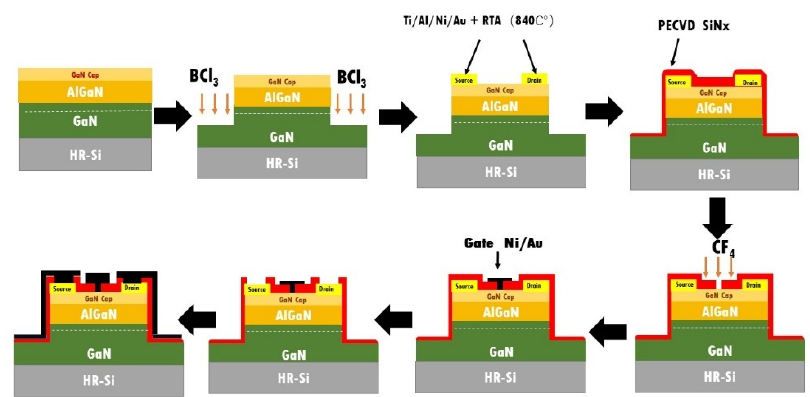
Figure 2. Schematic process flow of T-shaped AlGaN/GaN HEMT.